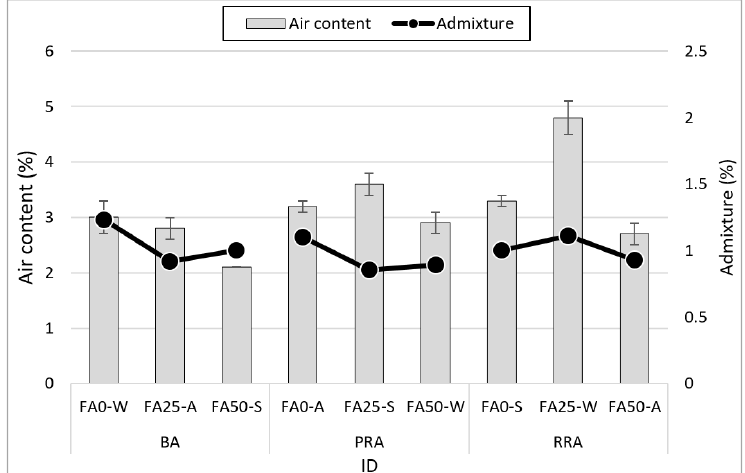
Figure 6. Air content of fresh concrete.